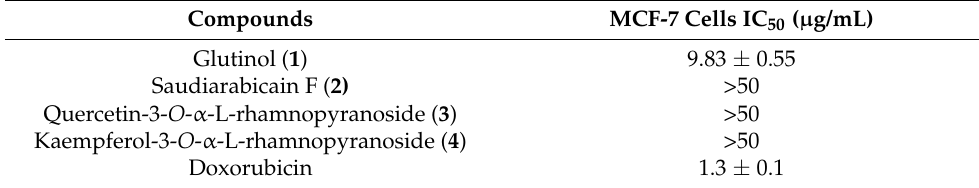
Figure 4. Viability percentages of MCF-7 cells treated with compound 1. Cells were treated with the indicated concentration of compound 1 for 48 h and their viability was assessed by MTT assay. Results are expressed as Avg ± SD of three experiments. Table 2. Cytotoxic activities of compounds isolated from E. saudiarabica.